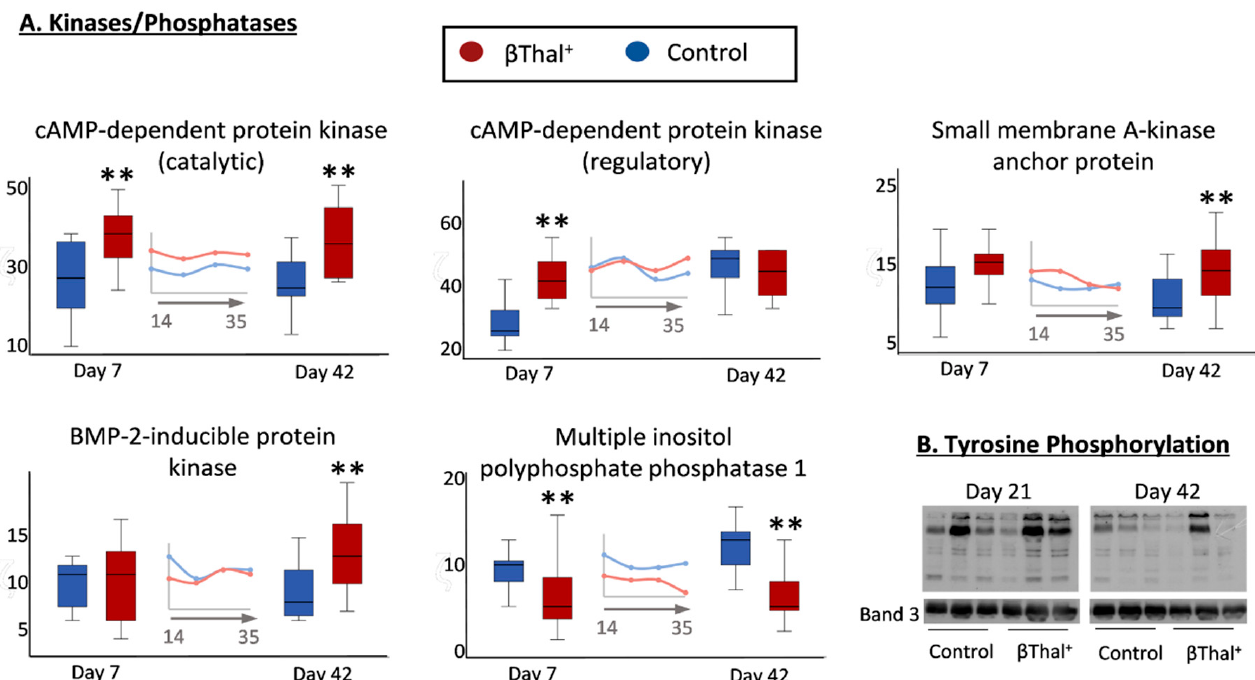
Figure 6. Proteomics analysis of stored RBC membrane: protein phosphorylation. ( A ) Levels of membrane-bound cytosolic protein kinases and phosphatases in β Thal + and control RBCs throughout storage. Inserts: pooled analysis of membrane samples at weekly intervals. (*) p < 0.05 β Thal + vs. controls; (**) p < 0.05 and fold > 1.25 β Thal + vs. controls. ( B ) Representative immunoblots showing variation in the levels of protein Tyrosine phosphorylation in β Thal + and control RBC membrane samples treated with phosphatase inhibitors ( n = 3 per group) at middle and late storage. Band 3 was used as the internal loading control.